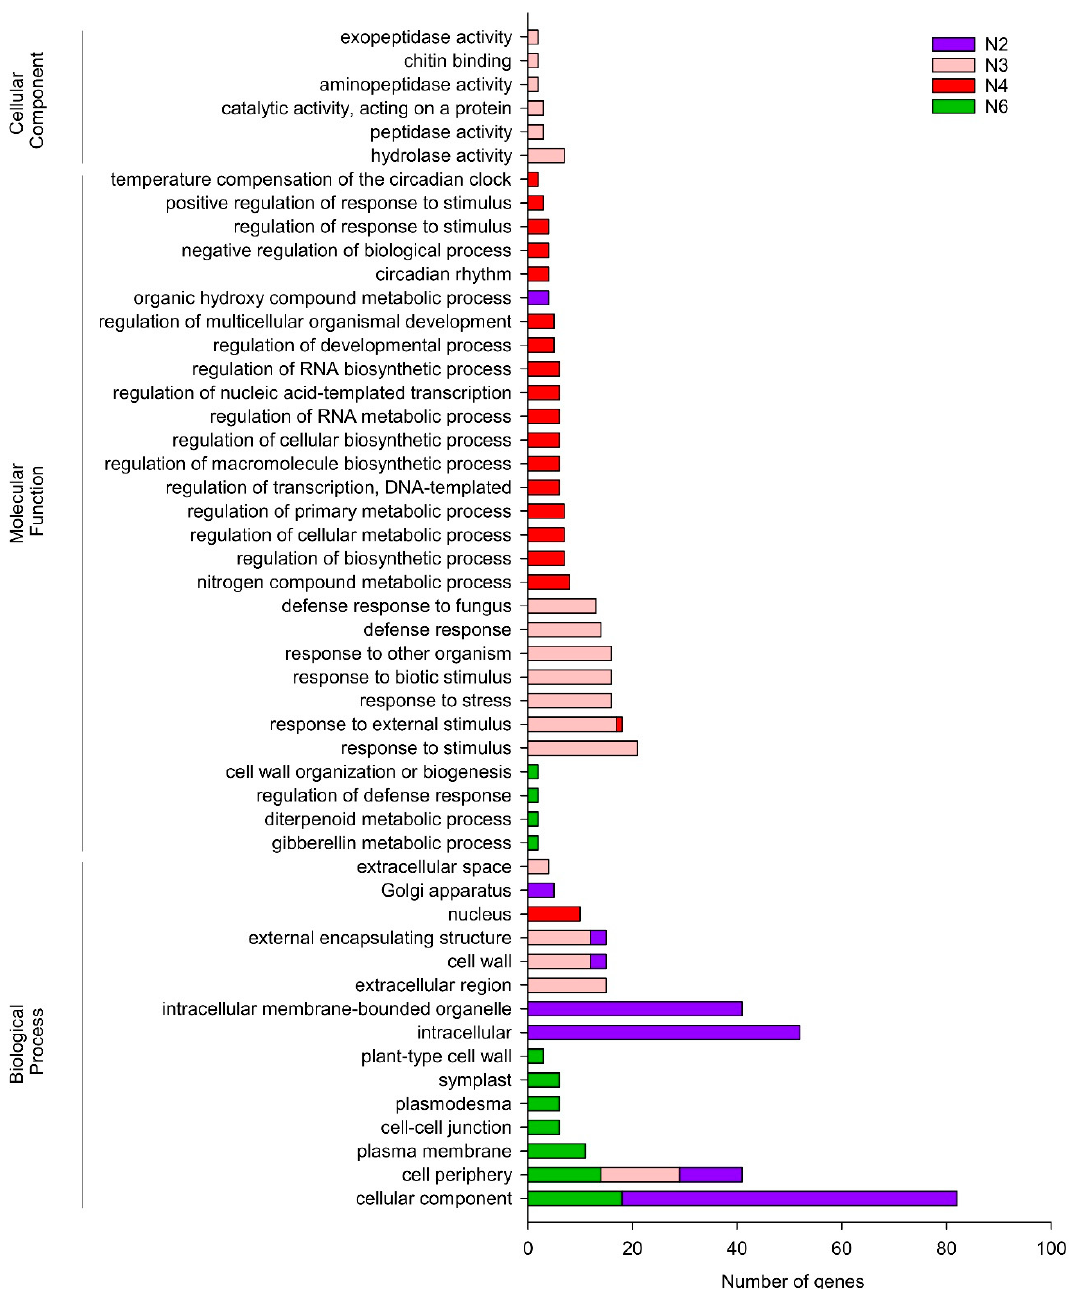
Figure 4. Gene ontology (GO) term enrichment analysis of differential gene expression in the